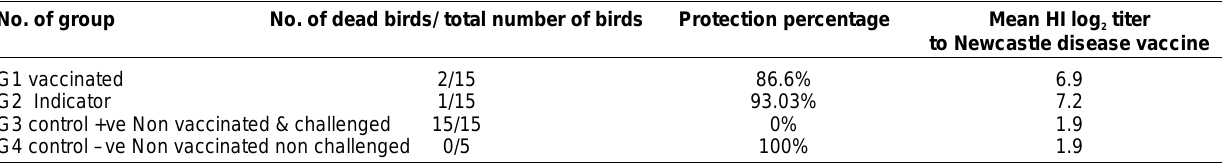
Table-2. Evaluation of the immunosuppressive effect of the prepared living TC IBD vaccine No. of